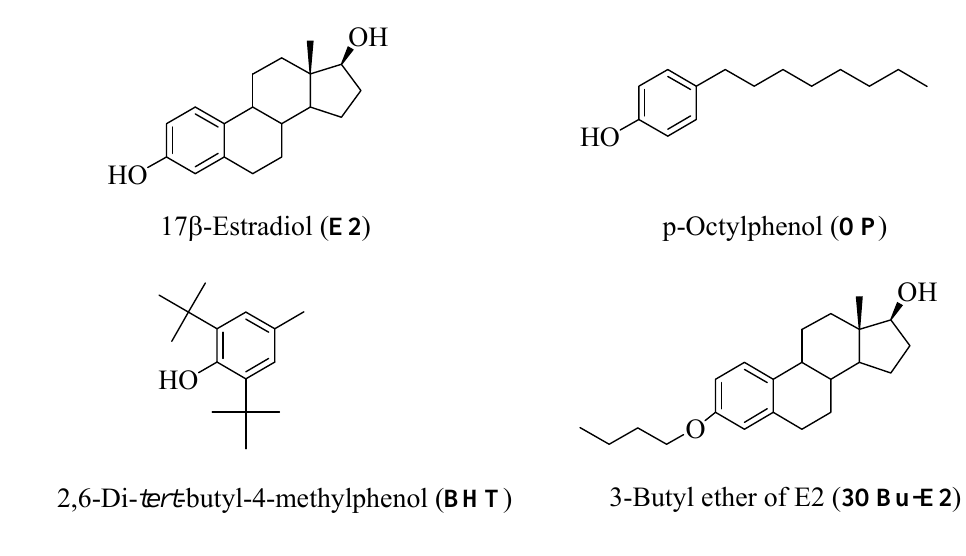
Figure 1. Chemical structures of E2, OP, BHT and